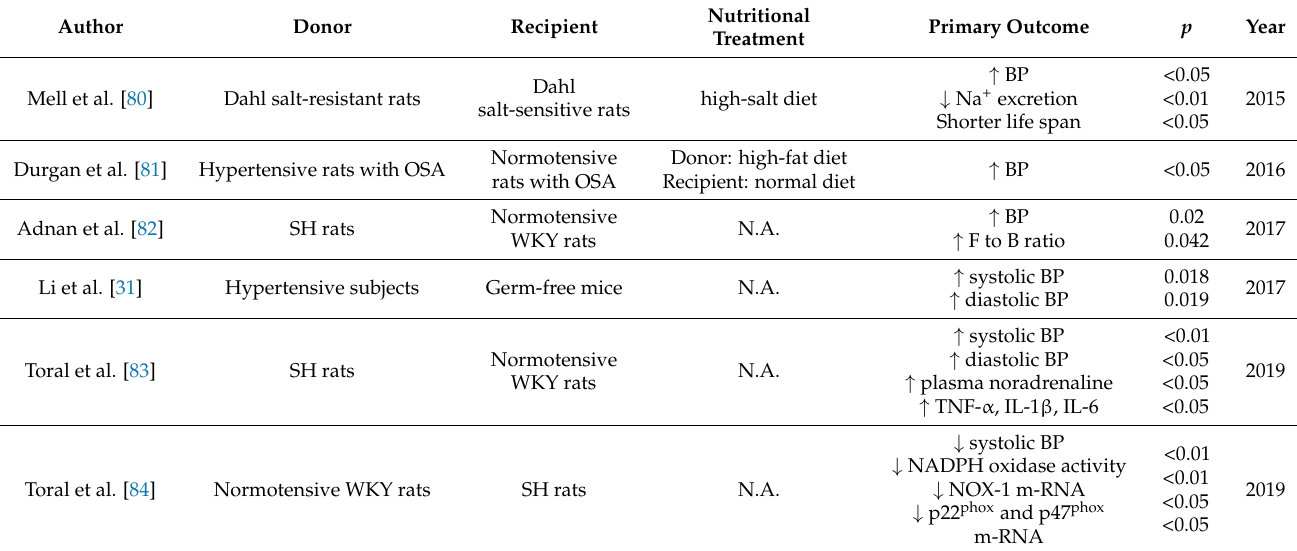
Table 1. Fecal microbiota transplantation studies in hypertensive animals and